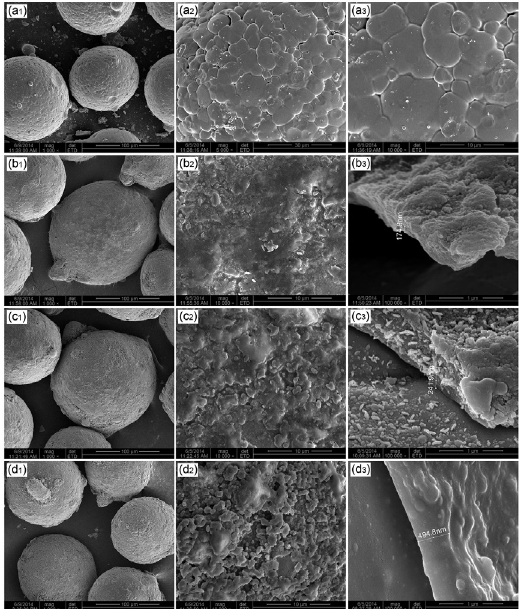
Figure 1: FE-SEM images of ferrosilicon particles: (a) uncoated, (b) coated 20 times, (c) coated 25 times, and (d) coated 40 times at different